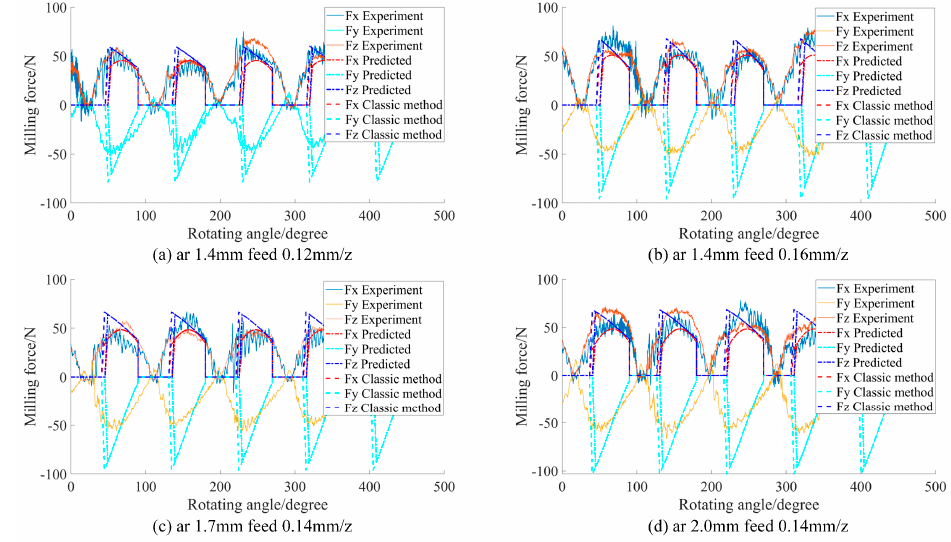
Figure 11. Comparison between experiment and simulation under different processing parameters.